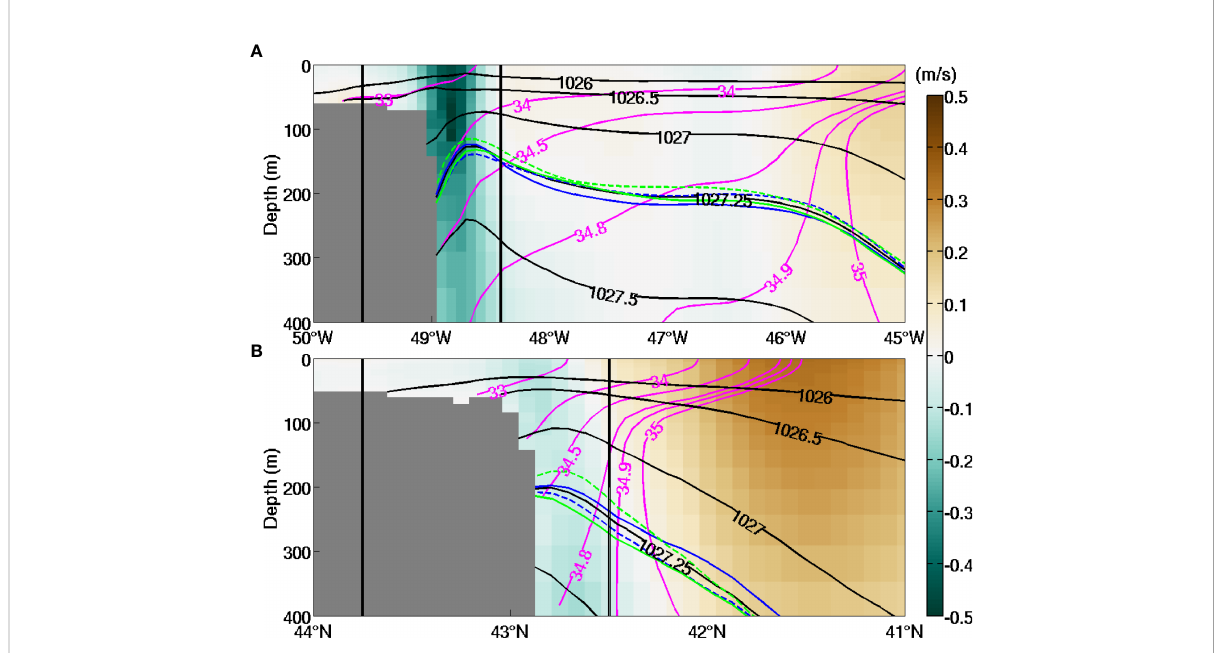
FIGURE 2 Velocity, salinity and potential density averaged over 1993-2018 on sections at (A) 45°N, and (B) 50°W. Colors present the meridional velocity (northward as positive) in (A) and zonal velocity(eastward as positive) in (B) . The magenta and black contours are the isohalines and isopycnals averaged for all the seasons. The seasonal variations of the 1027.25 kg/m 3 isopycnals are presented using the solid blue (Winter: January to March), dashed blue (Spring: April to June), solid green (Summer: July to September), and dashed green (Fall: October to December) curves. The two vertical black lines show the locations of sections B and